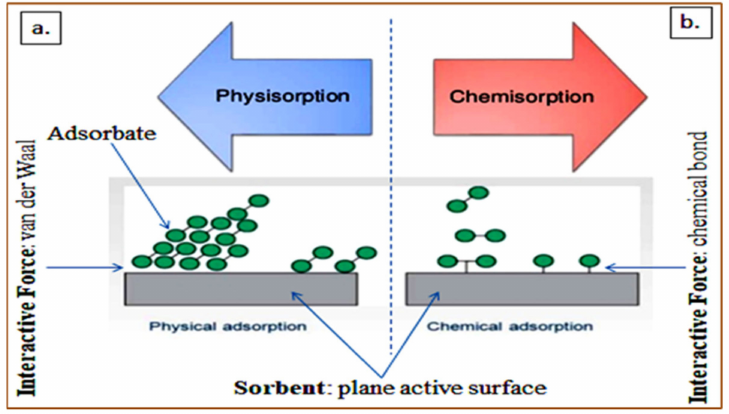
Figure 3. Adsorption mechanisms of ( a ) physisorption and ( b ) chemisorption. (https://www.slideshare.net/jaskiratkaur28/adsorption-isotherms-81552835) accessed 20 June